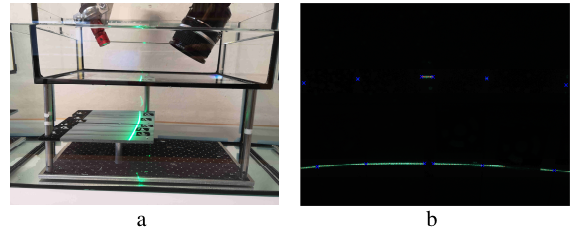
Figure 7: Calibration set-up (a) and image (b) with corresponding points on both levels (blue crosses) and additional points across the line (red